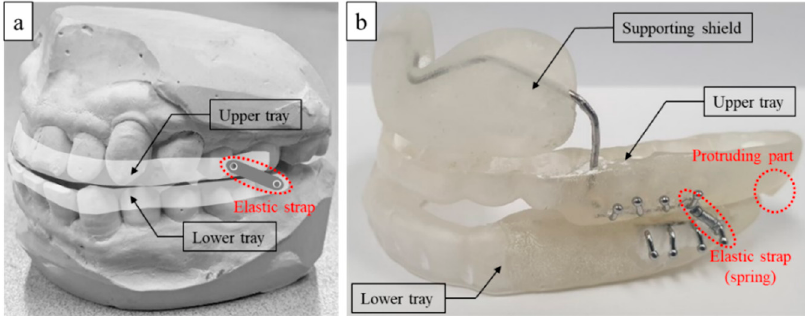
Figure 1. Mandibular advanced device (MAD): ( a ) conventional type and ( b ) prototype of the proposed MAD.